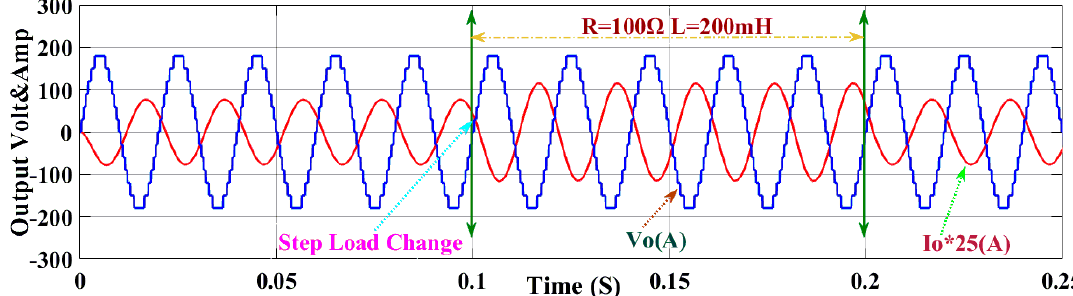
Figure 8. Simulation voltage and current waveform for different modulation indices.